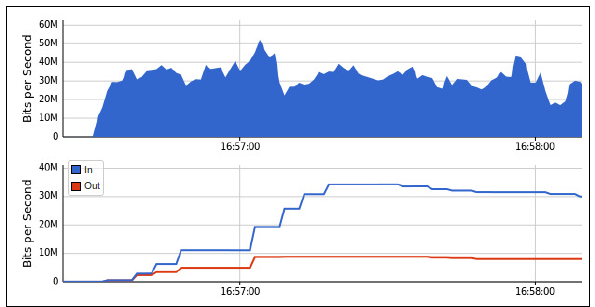
Figure 7. Unprotected DoS Flow Network Load